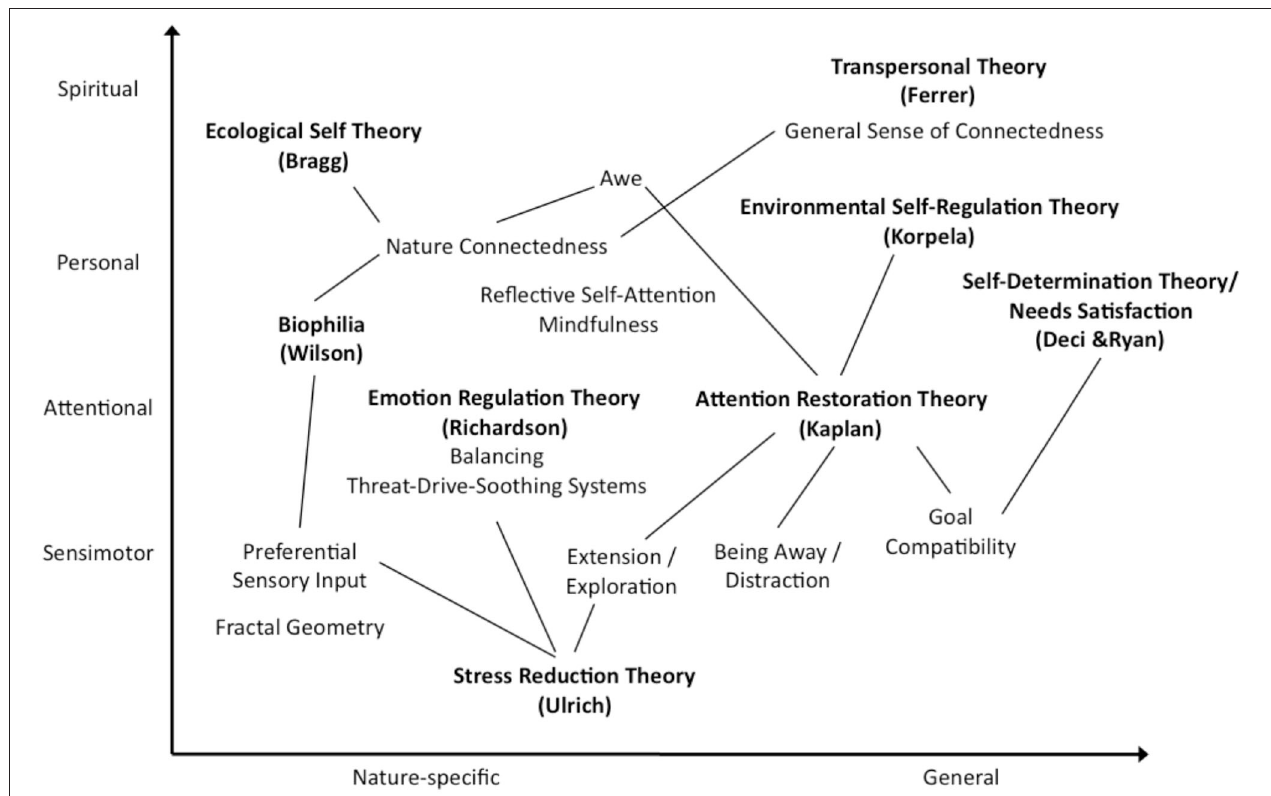
FIGURE 1 | A visualization of the relationship between theories of the well-being benefits of nature engagement. The x-axis represents the degree to which the theory tends to focus on mechanisms that are specific to the biological affinity of humans with natural environments (e.g., evolved biological systems, ecological identity), vs. more general psychological mechanisms that are nonetheless facilitated by nature (e.g., attention, self-regulation), and the y-axis represents the level of abstraction of the components of the theory, from sensimotor processes, through attentional, personal (self-related), and spiritual (transpersonal) components. The ecological-existential/phenomenological-psychoanalytical approach by Brymer et al. encompasses the full spectrum of both